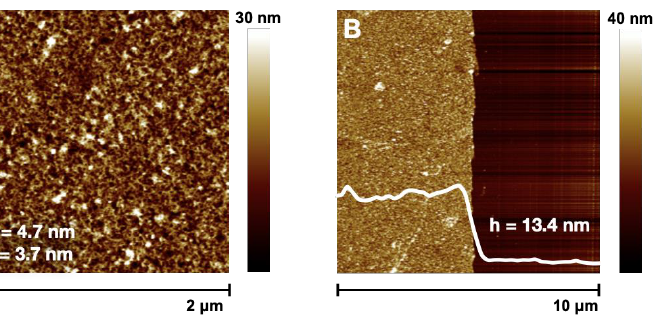
Figure 3. AFM pictures of poly( St-D - alt - Ma-A ) brushes obtained via metal-free ATRP polymerization: ( A ) topography; ( B ) thickness of the layer.